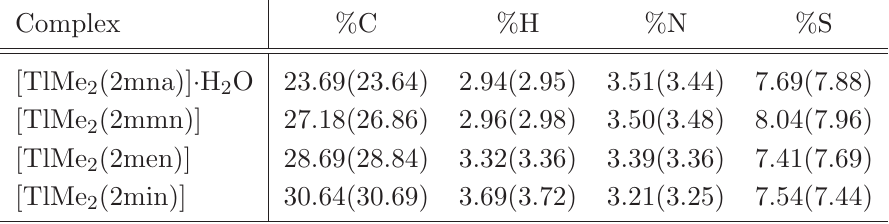
Table 2 Analytical data for [TlMe 2 (L)]